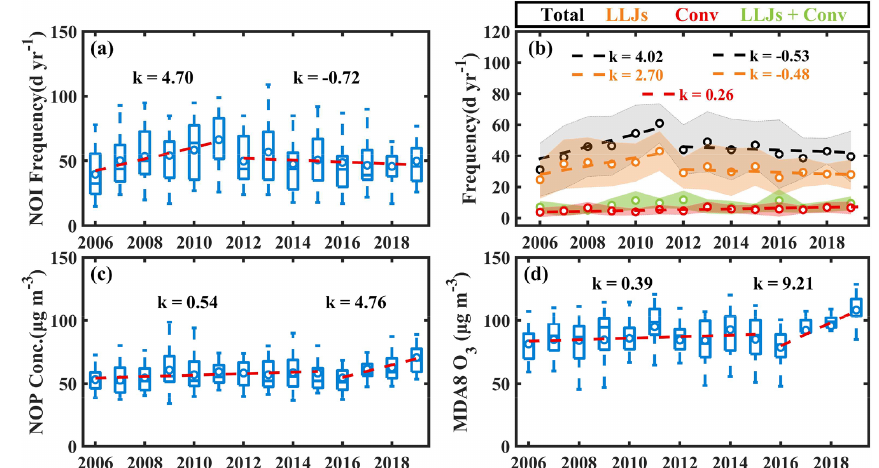
Figure 3. Regional-average annual trends of (a) frequency of NOI events; (b) frequency of total downdrafts (black), LLJs (orange), LLJs+Conv (green), and Conv (red) that can induce NOI events; (c) NOP concentrations; and (d) MDA8 O 3 concentrations in the PRD region during 2006–2019. The units of k (Sen’s slope) are d − 1 yr − 1 in (a, b) and µgm − 3 yr − 1 in (c, d) . Linear trends significant at the 95% confidence level are illustrated with dashed lines. The error bars indicate the range of deviations for the 16 air quality